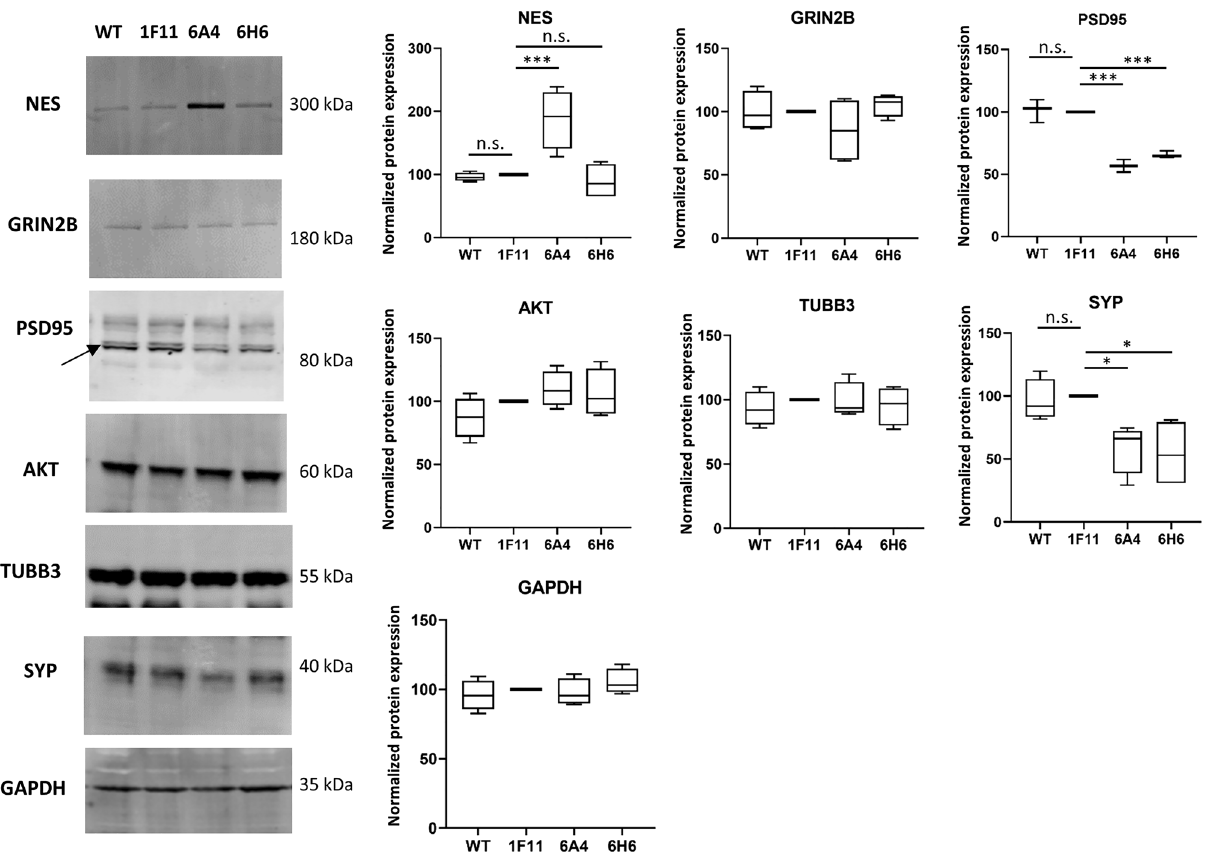
Figure 4. Quantification of protein expression in SH-SY5Y cells (7 days after differentiation). Western blot analysis with protein from two control and two SHANK2 mutant cell lines. The protein expression levels of NESTIN (NES), GRIN2B, PSD95, AKT, β3-Tubulin (TUBB3) and SYP were normalized against the expression of GAPDH (reference). GAPDH expression was analyzed against total protein expression and a differential expression of GAPDH between the different cell lines was ruled out. No differences between the two control lines WT and 1F11 could be detected. Differential expression levels between mutant and control cell lines were found for NES, PSD95 and SYP. Cropped western blot membrane images are shown and full-length blots are presented in Supplementary Fig. 8. n = 5 experiments, one-way ANOVA was carried out and protein expression of the two mutant cell lines (6A4, 6H6) and the wildtype cell line (WT) was compared against the control 1F11 (ANOVA results: NES F = 11.57, P = 0.0007; GRIN2B F = 1.21, P = 0.348; PSD95 F = 63,51, P < 0.0001; AKT F = 1.91, P = 0.181; TUBB3 F = 0.28, P = 0.837; SYP F = 6.48, P = 0.0074; GAPDH F = 0.93, P = 0.458). n.s.—not significant. Correction for multiple testing with Dunnett´s test (n = 3 tests for each protein). Data were presented as box-plots and the corrected P-values are indicated, *P ≤ 0.05, ***P ≤